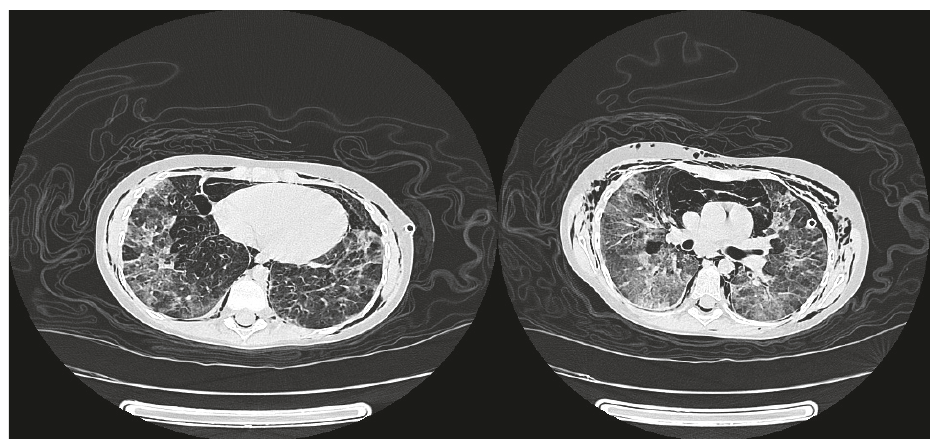
Figure 1: Severe emphysema in chest wall and bronchiectasis in spiral chest CT